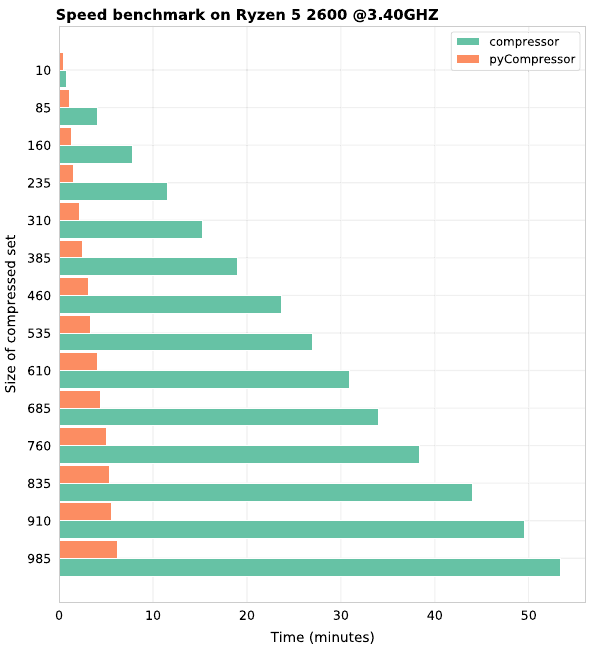
Fig. 16 Speed benchmark comparing the compresssor and pyCompressor codes using the GA as a minimization for 1500 itera- tions. For the purpose of this benchmarks, the parameters that enter into the GA are chosen to be exactly the same across both implementations Table3 Comparisonofaveragecomputingresourcesbetweenoursand the previous implementation when compressing to N c = 500 replicas from a prior with 1000 Monte Carlo PDF replicas Nb.